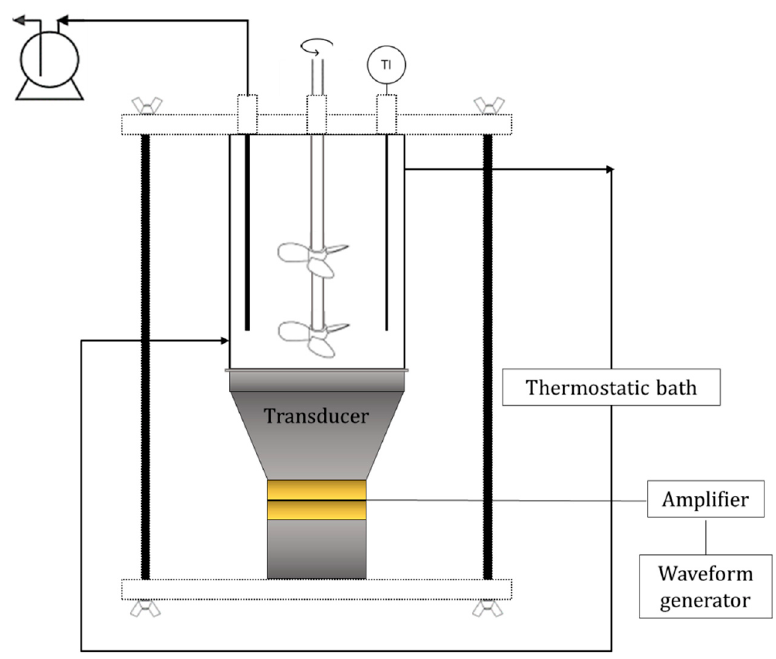
Figure 10. Experimental set-up for the ultrasound-assisted